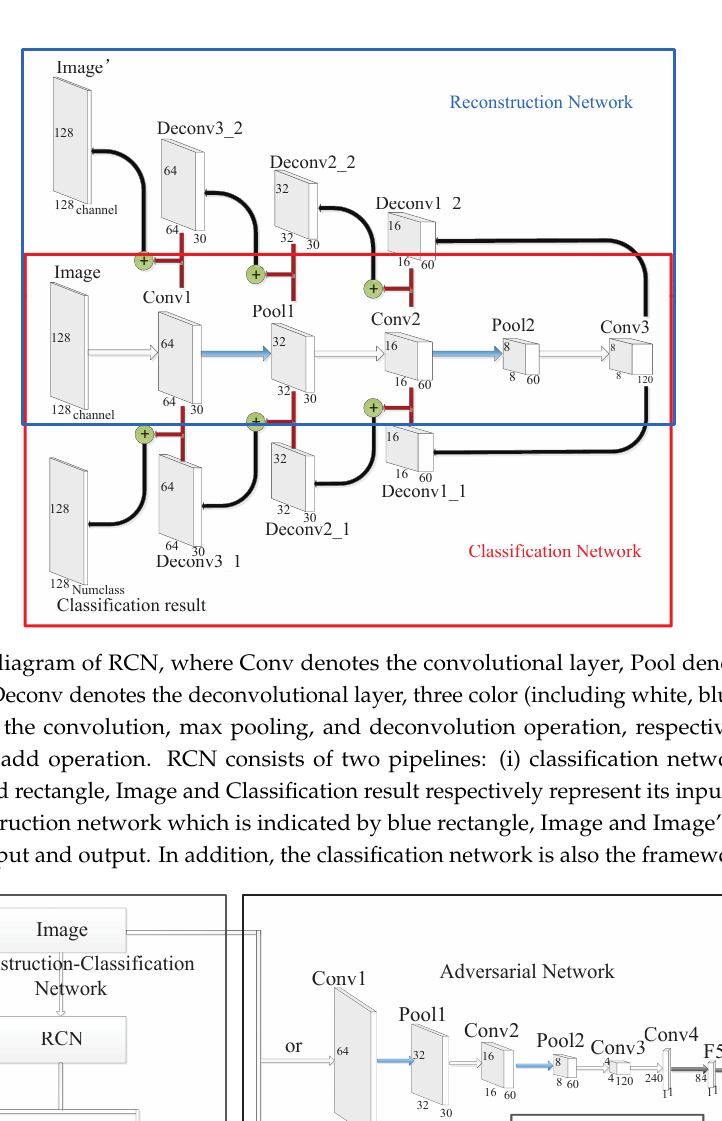
Figure 2. The left black rectangle in Figure 2 represents the RCN model, which takes Image as input and produces the classification result and the reconstruction of the Image. Meanwhile, the right black rectangle takes image map as input and produces class label (1 = true image, or 0 =